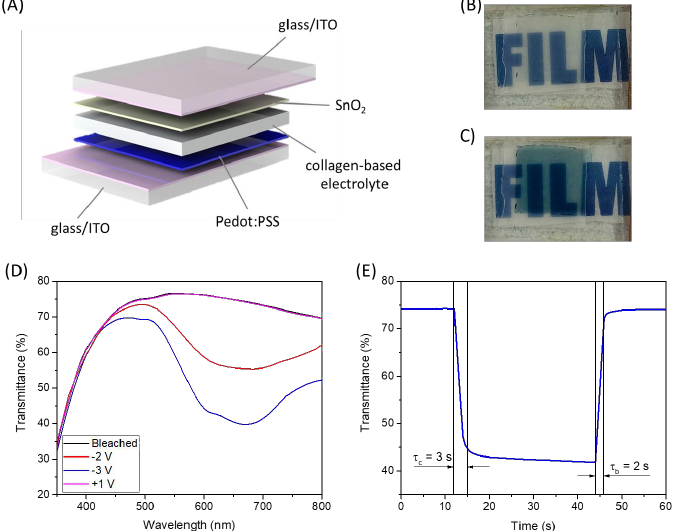
Figure 8. ( A ) Schematic representation of the fabricated electrochromic device; ( B ) picture of the device in the bleached state; ( C ) picture of the device in the colored state; ( D ) electromagnetic spectra of the electrochromic device in the visible range at different applied voltages; ( E ) transmittance (650 nm) vs. time spectrum by changing the potential between 1 V and −3 V.